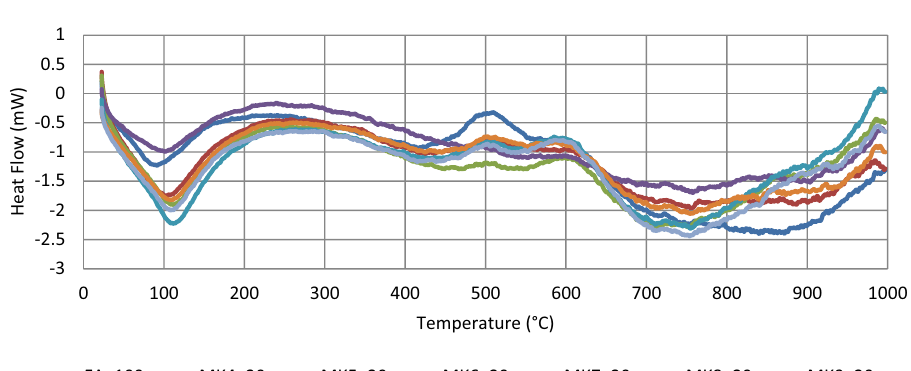
Fig. 10 DSC curves for geo- polymer pastes